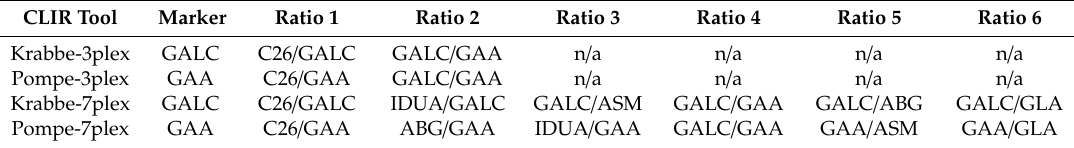
Table 1. Markers and ratios used in NY3-plex and